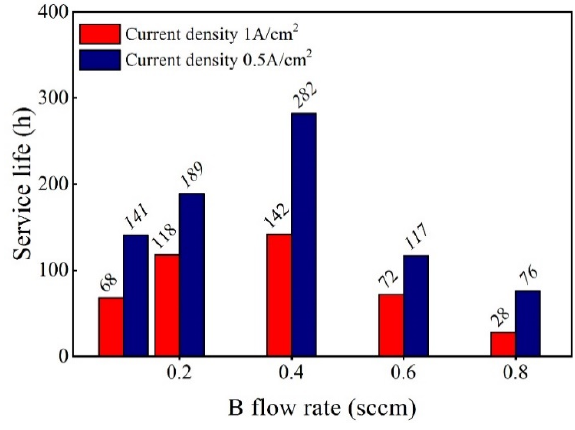
Figure 5. The e ff ect of the B source flow rate on the ALT life of the Ti / BDD coated Figure 5. The effect of the B source flow rate on the ALT life of the Ti/BDD coated electrodes. 196